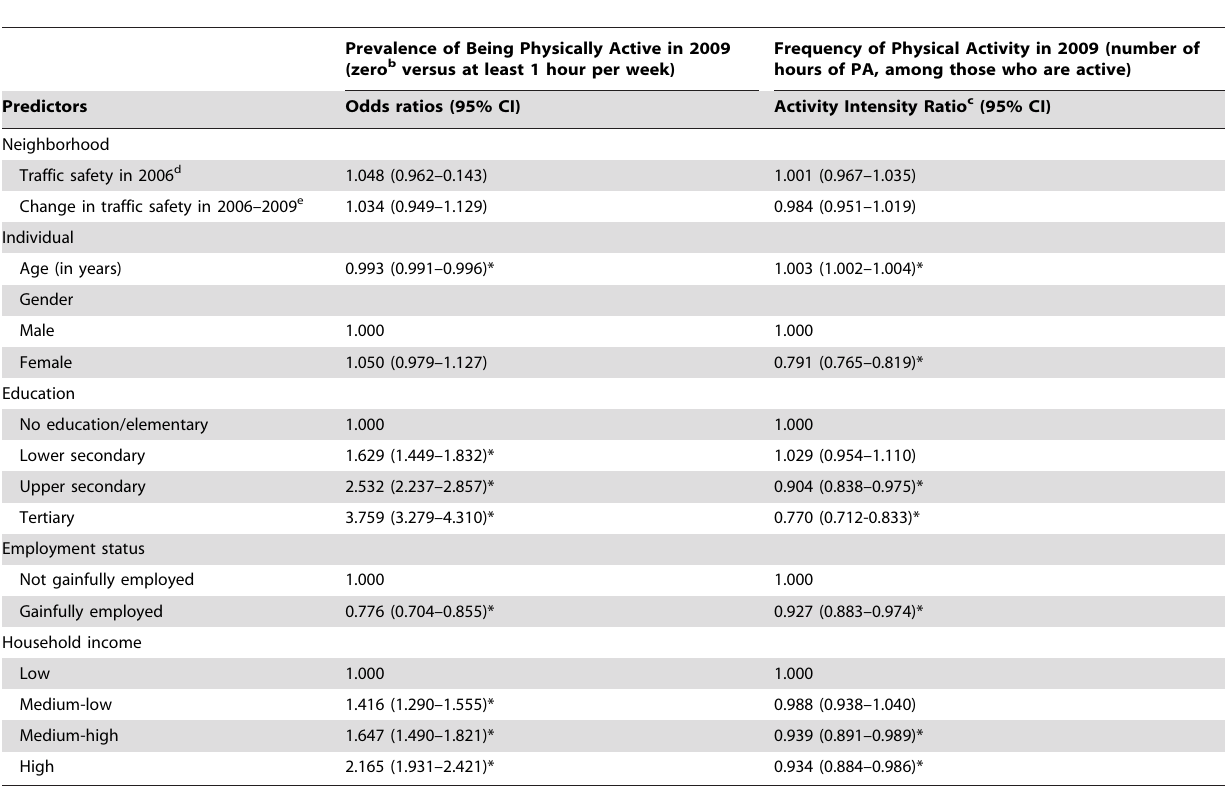
Table 6. Association of physical activity in 2009 with traffic safety in 2006 and change in traffic safety between 2006 and 2009, and sociodemographic variables, for 2009 respondents a